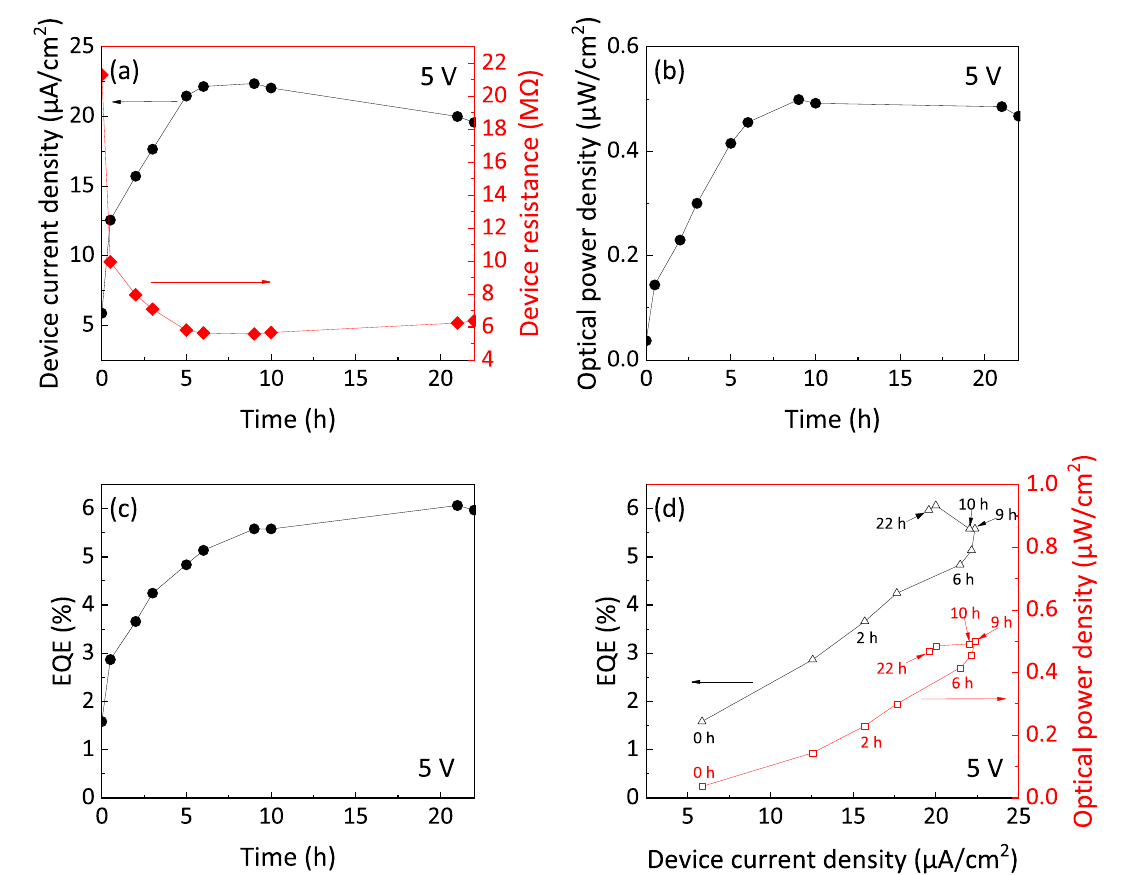
Figure 6. Device characteristics of ( a ) device current density and device resistance, ( b ) optical power, and ( c ) external quantum efficiency (EQE) plotted with time of voltage application. ( d ) The EQE and optical power plots with device current density during voltage application up to 22 h. Here, a constant voltage of 5 V was applied into the device.